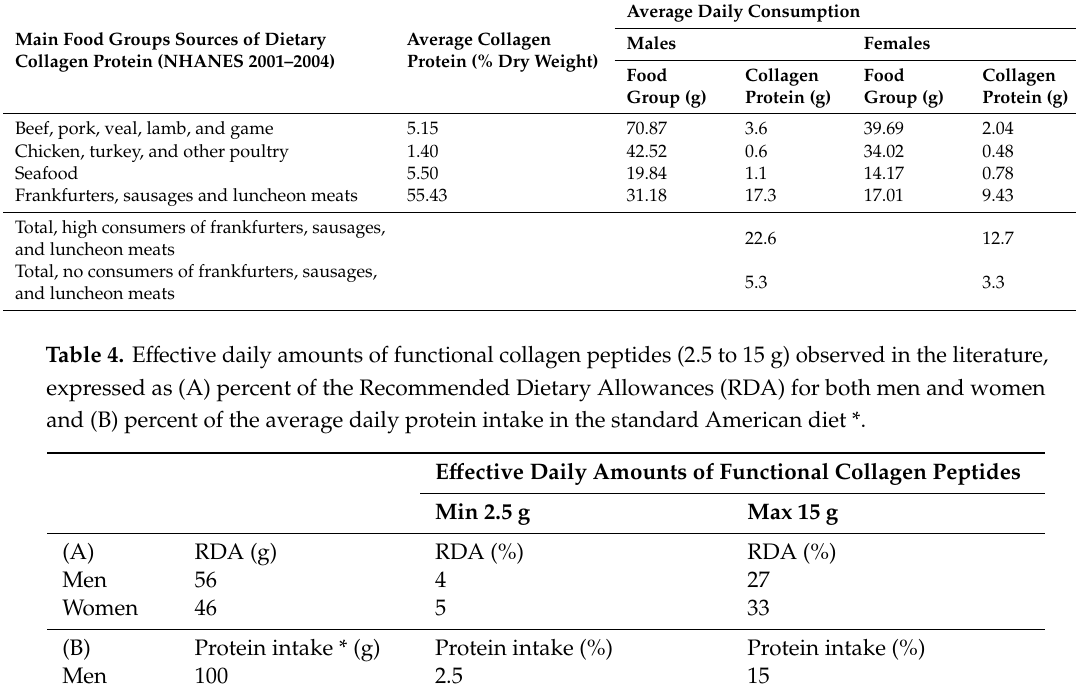
Figure 1. Illustration of the balance between indispensable and dispensable amino acids when the total protein in the standard American diet is replaced with 36% collagen peptides ( (cid:4) ) compared to the predominance of indispensable amino acids in the standard American diet ( (cid:4) ). Absolute values are based on the amino acid composition of the standard American diet and collagen peptides of porcine origin sample D [27]. Table 3. Estimated average daily collagen protein consumption in the standard American diet by males and females, using NHANES data from 2001–2004.